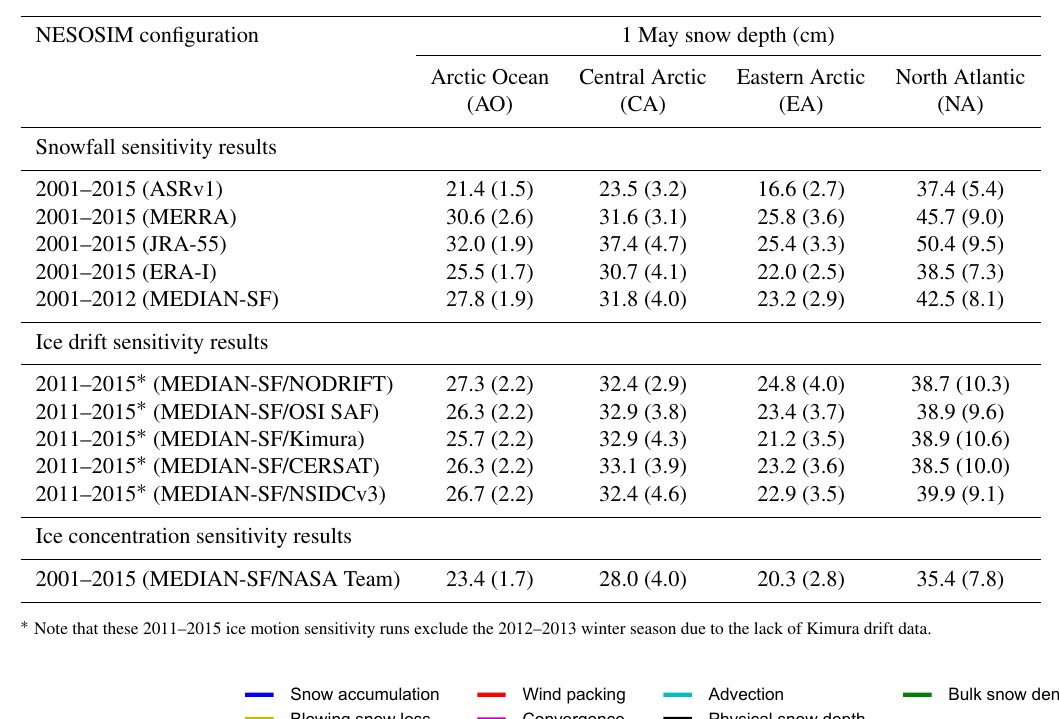
Table 4. Mean snow depths as of 1 May across the four study regions (rows, regions given in Fig. 5) for NESOSIM using different forcings and time periods (columns). The numbers in brackets represent interannual variability and are calculated as 1 standard deviation of the annual